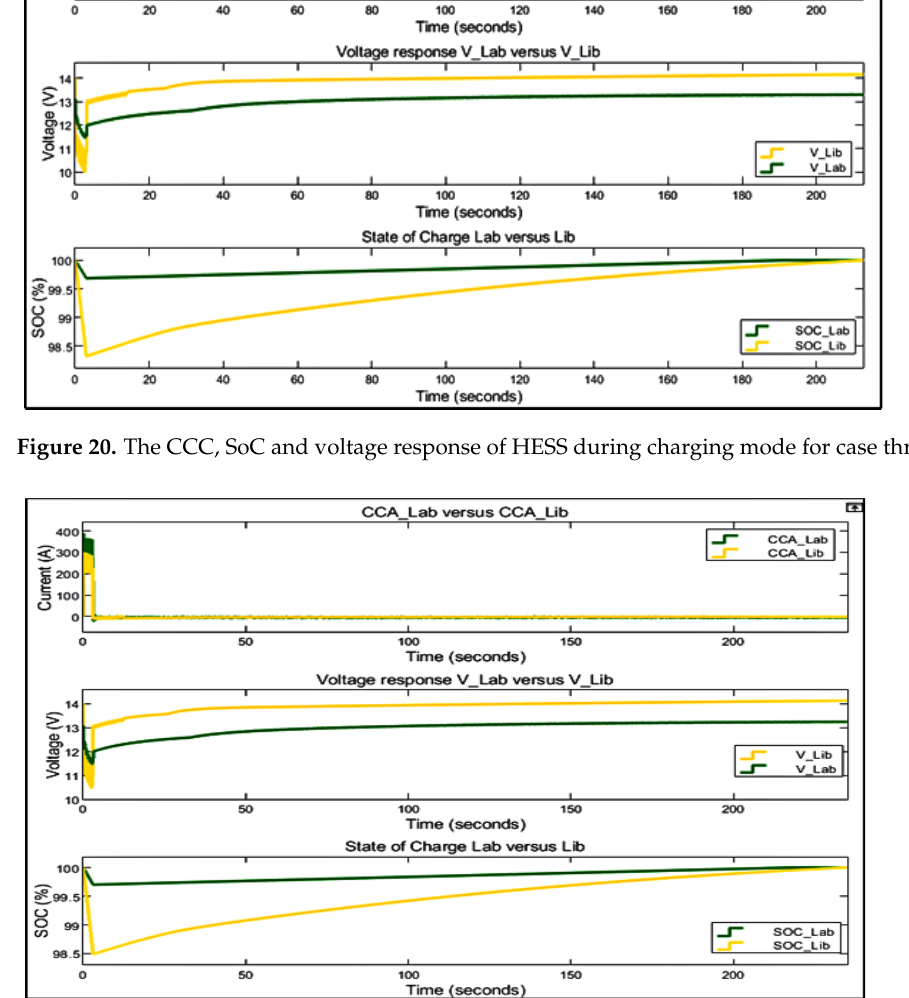
Figure 21. The CCC, SoC and voltage response of HESS during charging mode for case three